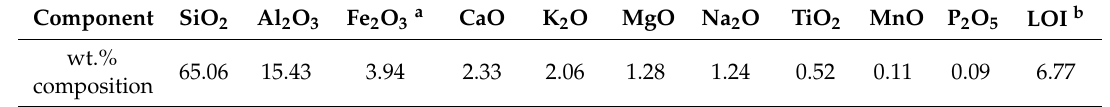
Table 1. Chemical composition of the calcium bentonite.